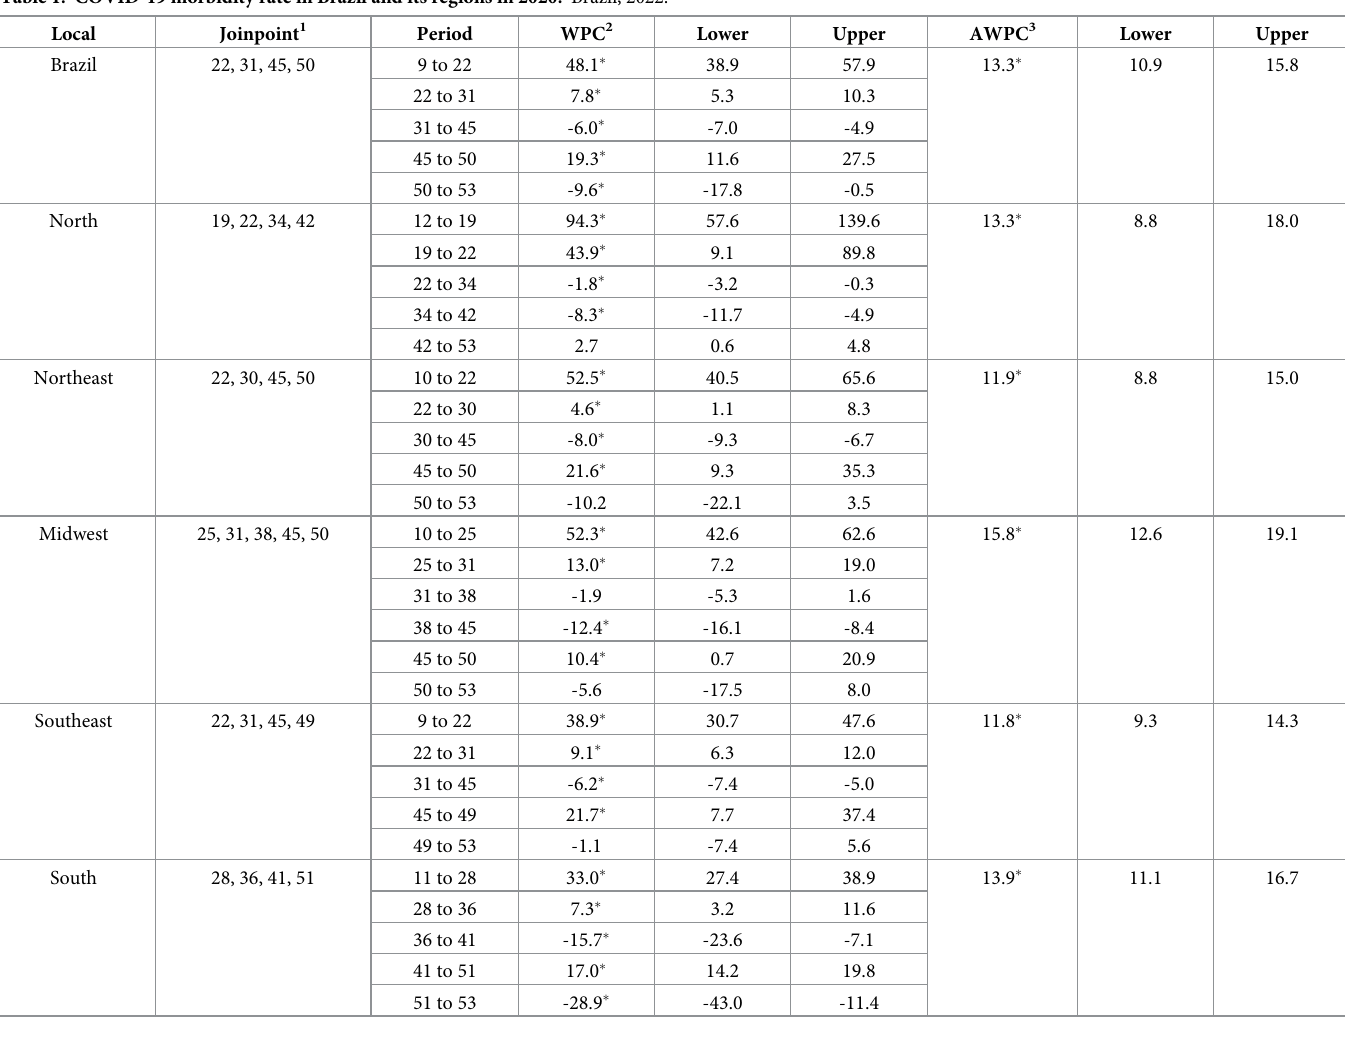
Table 1. COVID-19 morbidity rate in Brazil and its regions in 2020. Brazil, 2022. Local Joinpoint 1 Brazil